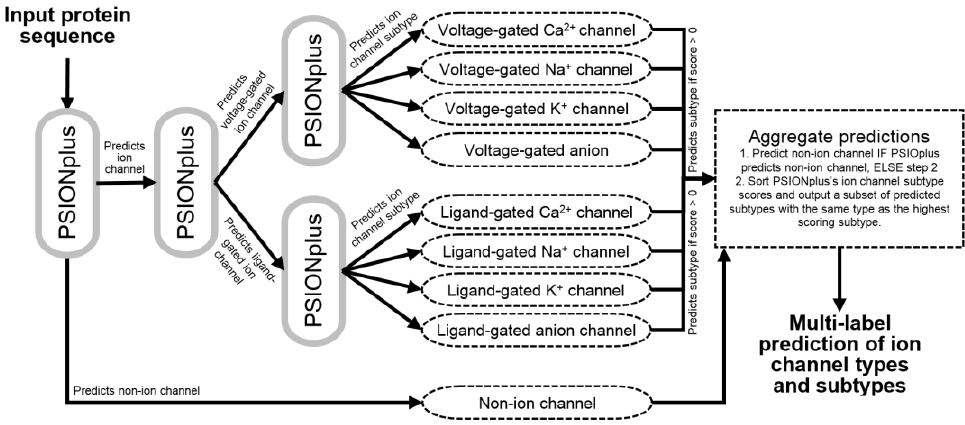
Figure 2. Flowchart of the prediction protocol implemented by PSIONplus m .